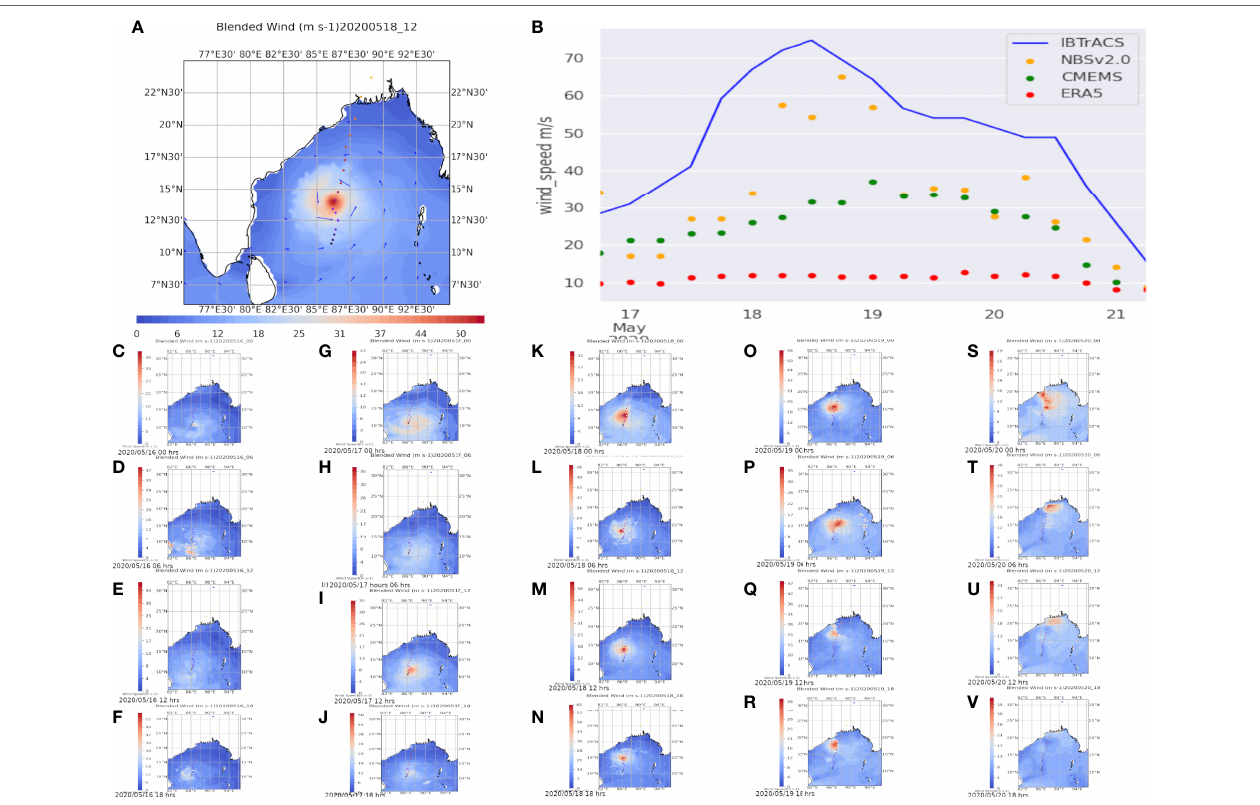
FIGURE 9 | (A) Wind speed with track available from IBTrACS data. (B) Time series of maximum wind along the track of the Tropical Cyclone (TC) Amphan. (C–V) Five days of wind data in and around the peak of the storm (on 18 May 2020), with different days (along the rows) and 4-hourly winds for each day (along the